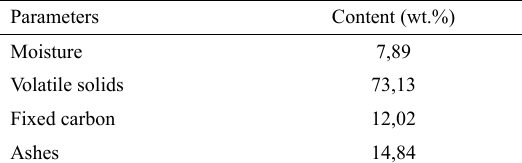
Table 2. Proximate chemical and elemental analysis of tobacco residue samples.